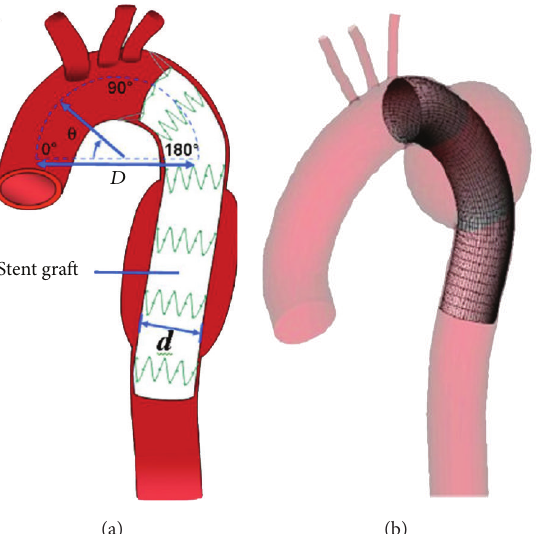
Figure 4: (a) The picture shows the factors affecting the drag force on stent graft which are the diameter of curvature, D , the internal diameter of stent graft, d , and the phase angle of curvature or the starting position of the graft, 𝜃 . (b) Mesh elements are created for the fluid domain. Adapted from [27].